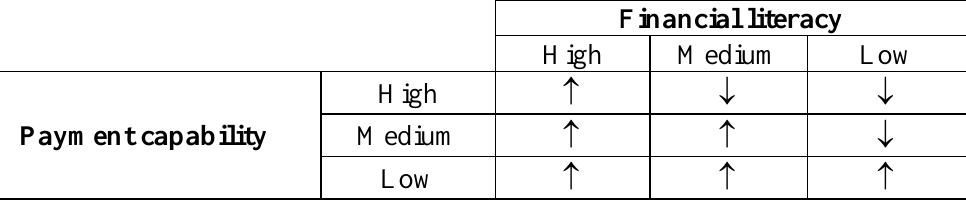
Table 1 . Different customer